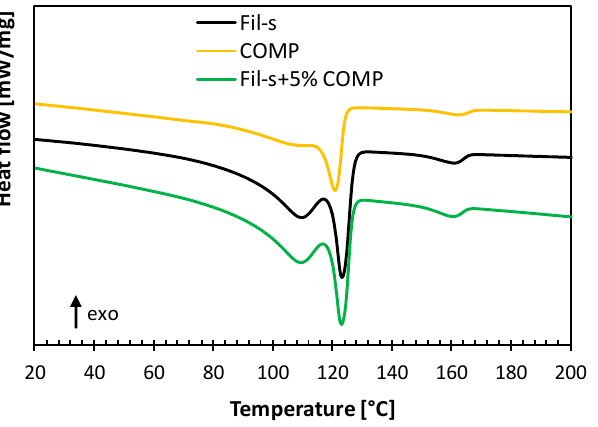
Figure 4. Comparison of the second heating thermograms of Fil-s, COMP and Fil-s + 5%COMP. The dynamic shear viscosity plots ( η *) for Fil-s, the compatibilizing agent and their blend are compared in Figure 5.